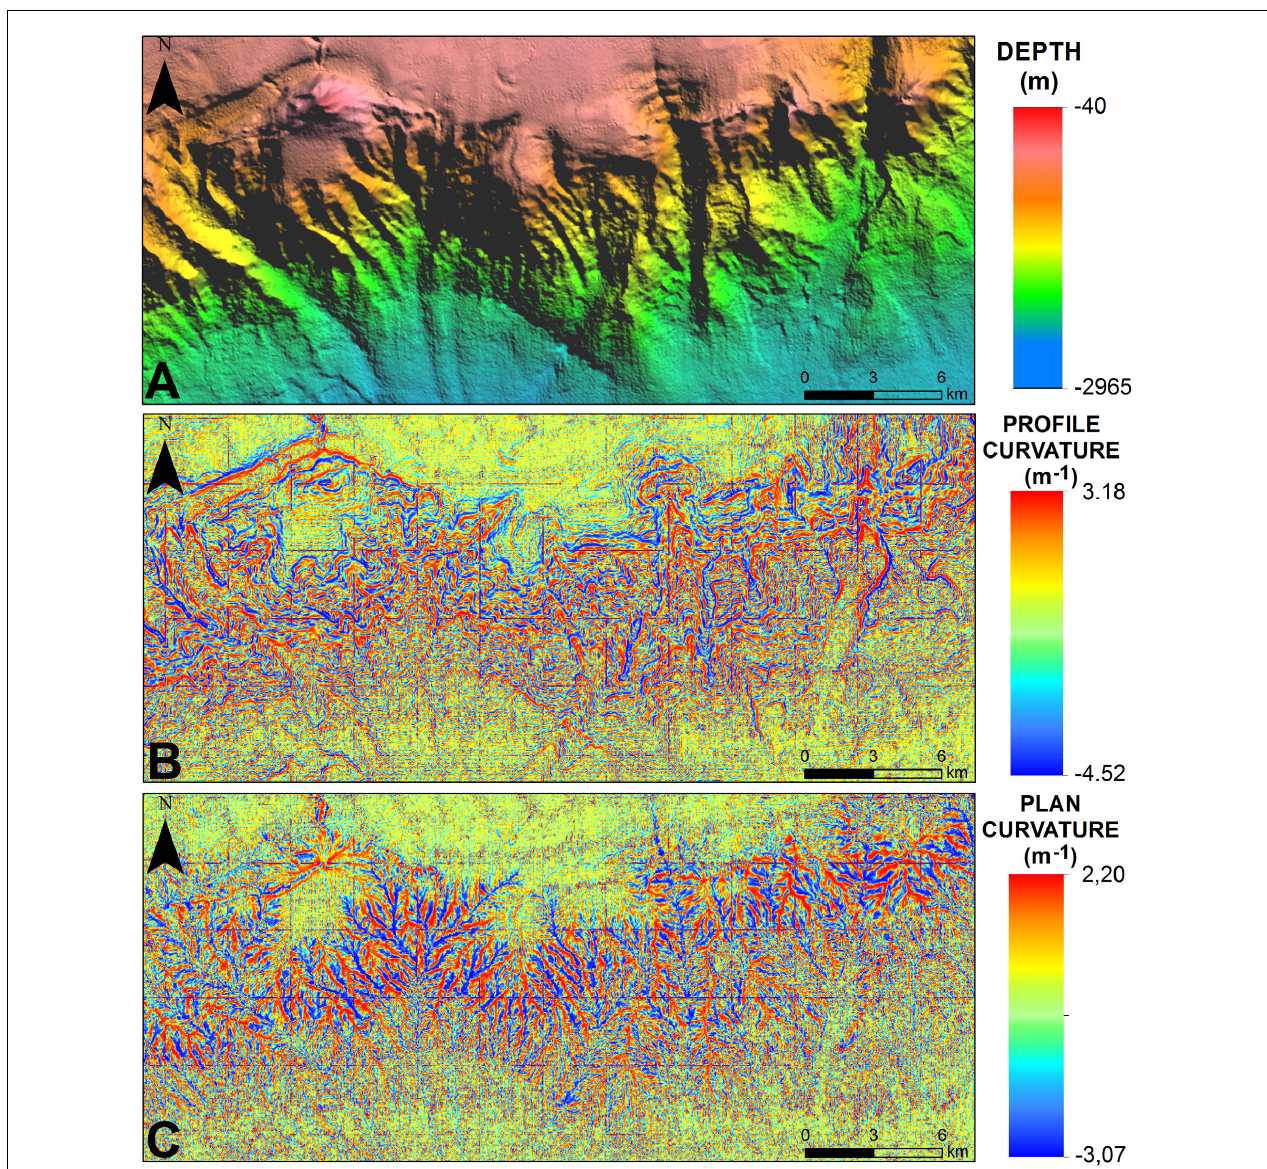
FIGURE 5 | Detail of Roncador southern escarpment. (A) Bathymetric model. (B) Profile curvature model. (C) Plan curvature model. See text for detailed description.